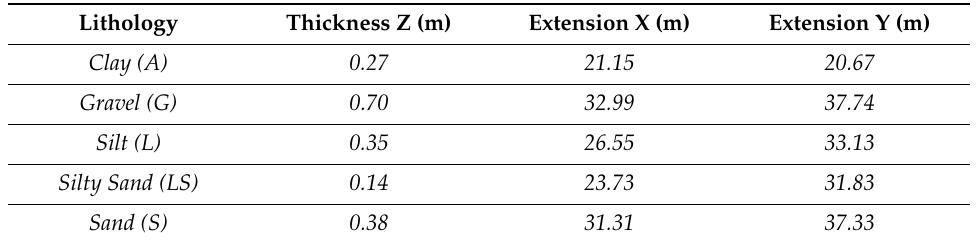
Figure 3. Normalized frequency distribution of lithologies ( a ); boxplot thickness for every lithology along direction Z (depth) ( b ); extension of the lithologies along the directions X ( c ) and Y ( d ). Table 1. Mean of thickness along Z, and its extension along the directions X and Y for the considered